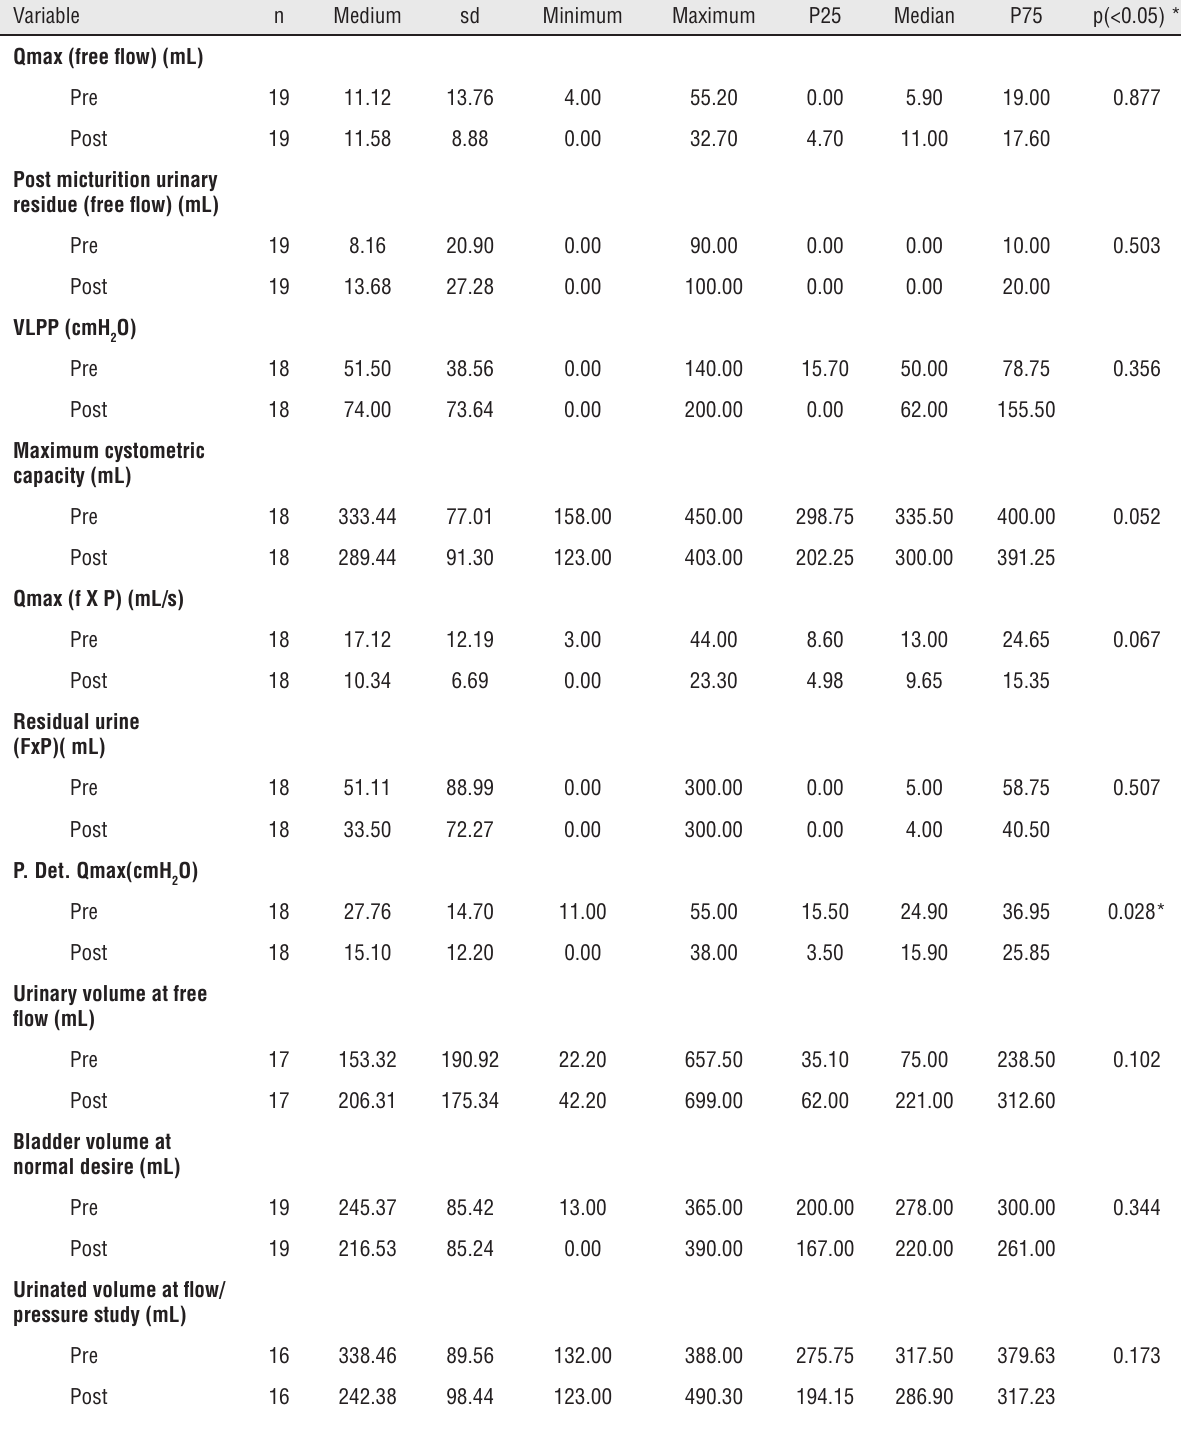
Table 3 - comparison of pre and post-operatory urodynamic